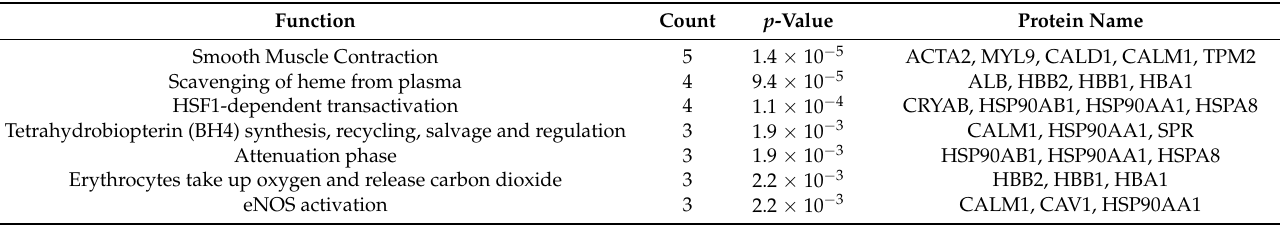
Table 3. Reactome pathway